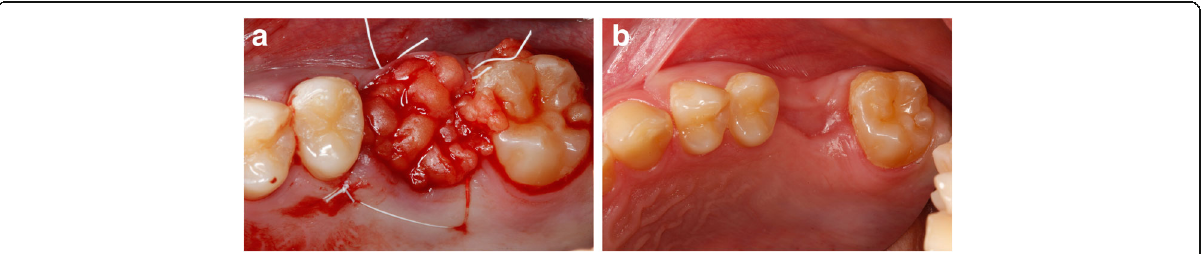
Fig. 10 a Closure by the buccal fat pad. b Healing after 3 months closure by buccal fat pad